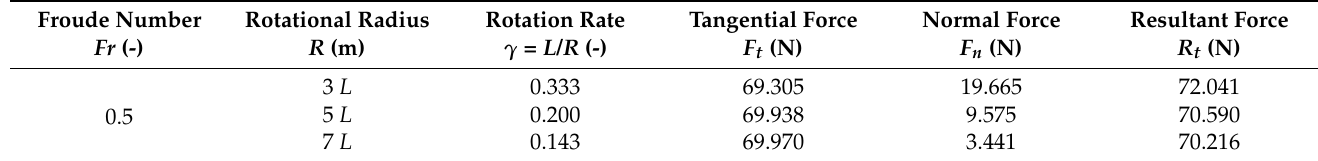
Table 5. Force component of the submarine at different rotation rates at Fr = 0.5.